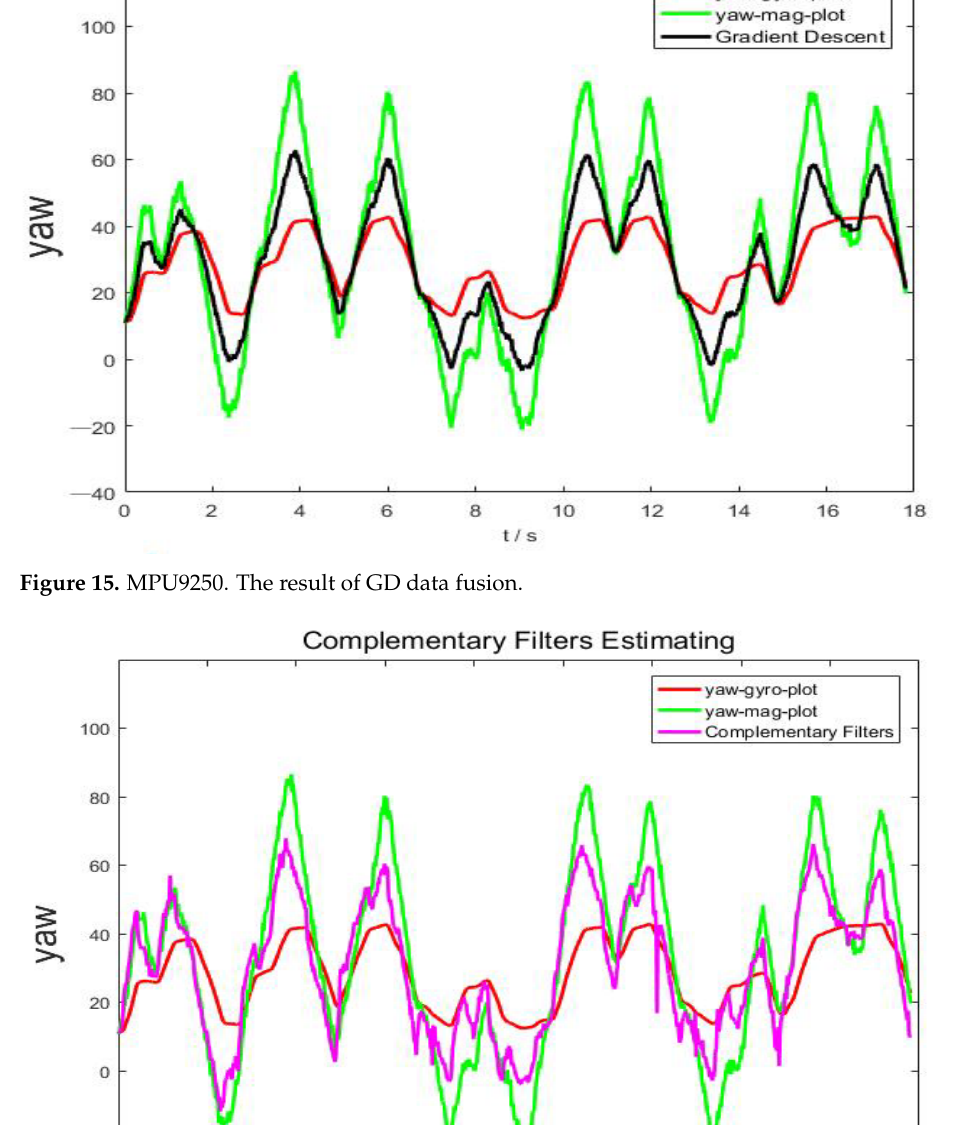
Figure 15. MPU9250. The result of GD data fusion.